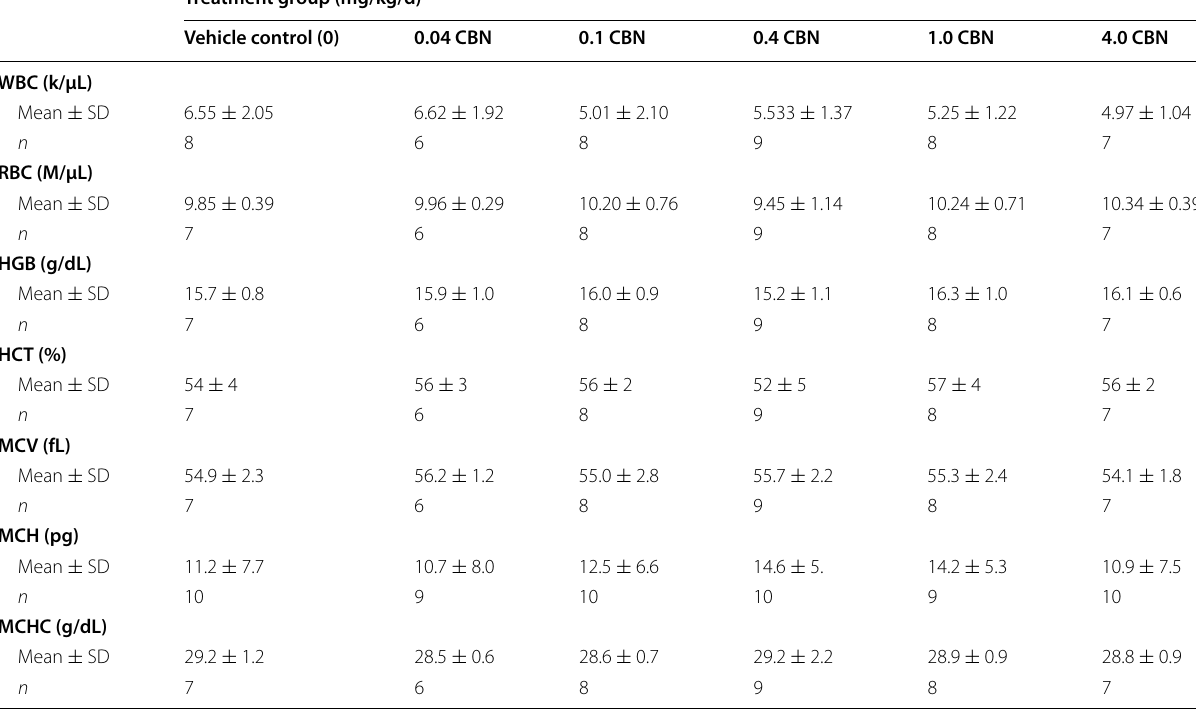
CBN Cannabinol, d day, HGB Hemoglobin, HCT Hematocrit, kg kilogram, MCH mean corpuscular hemoglobin, MCHC Mean corpuscular hemoglobin concentration, MCV mean corpuscular volume, mg milligram, RBC Red blood cell, SD Standard deviation, WBC White blood cell